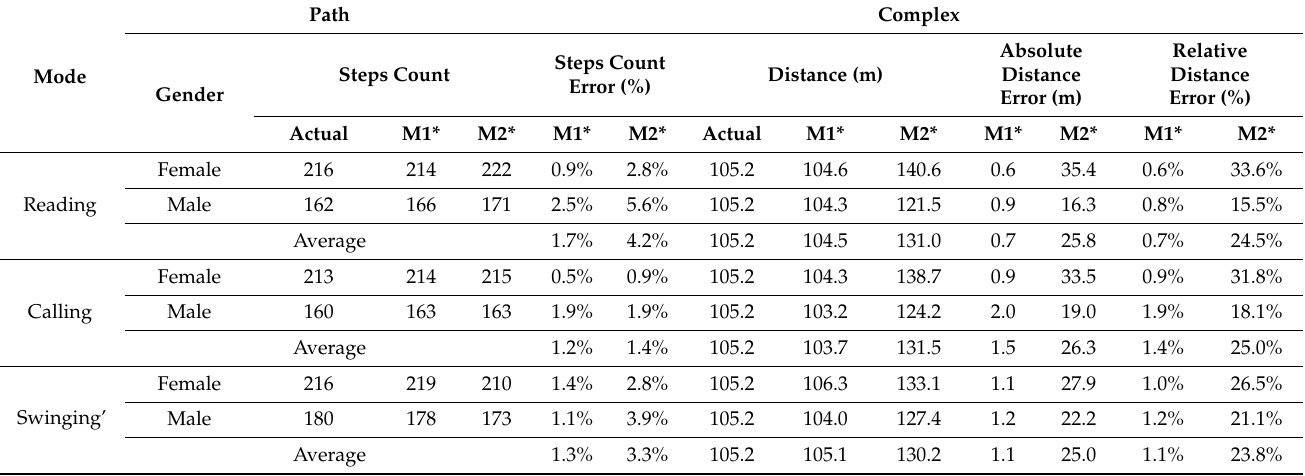
Table 9. Distance estimation on the 3D